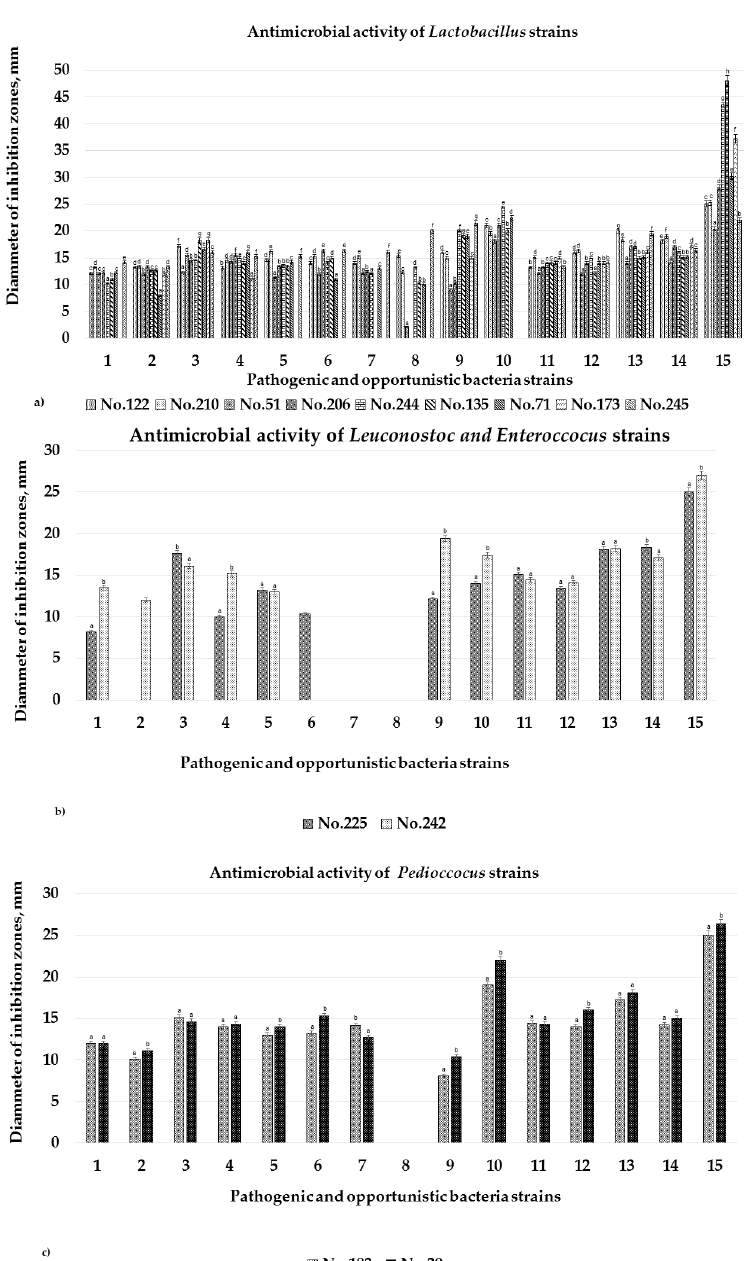
Figure 1. ( a – c ). Diameter inhibition zones (DIZ, mm) (Y axis) of the isolated sourdough lactic acid bacteria (LAB) strains against pathogenic and opportunistic microorganisms. Data expressed as mean values ( n = 3) ± standard deviation (STDV). The isolated sourdough LAB encompasses: